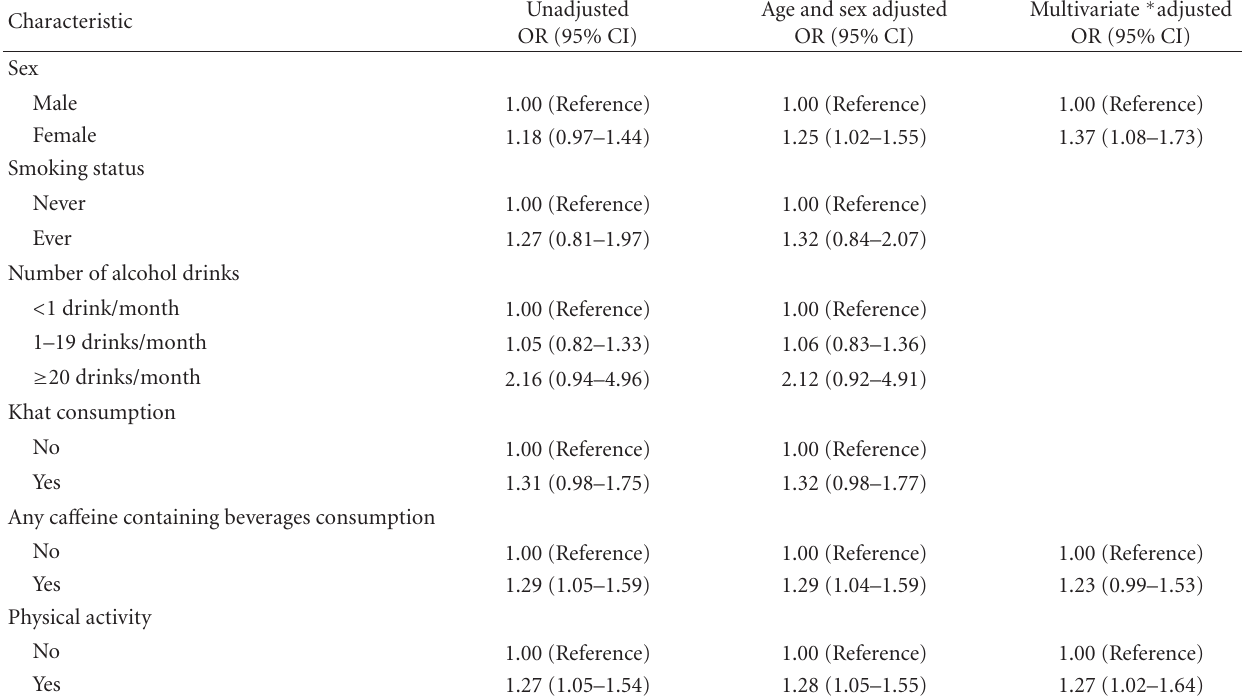
Table 3: Odds ratio (OR) and 95% confidence intervals (CI) for poor sleep quality.